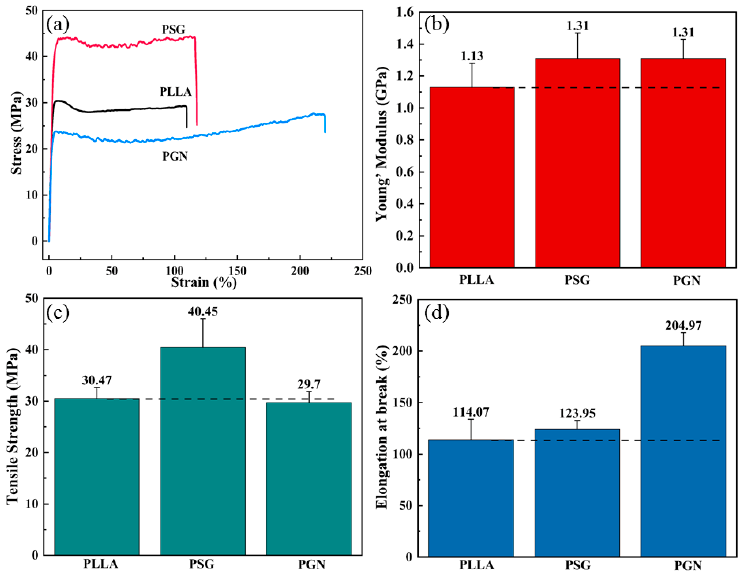
Figure 6. ( a ) Representative stress-strain curves for PLLA, PSG, PGN nanocomposite films; the var- iations of ( b ) Young’s modulus, ( c ) tensile strength, ( d ) elongation at break as a function of PLLA number of layers.